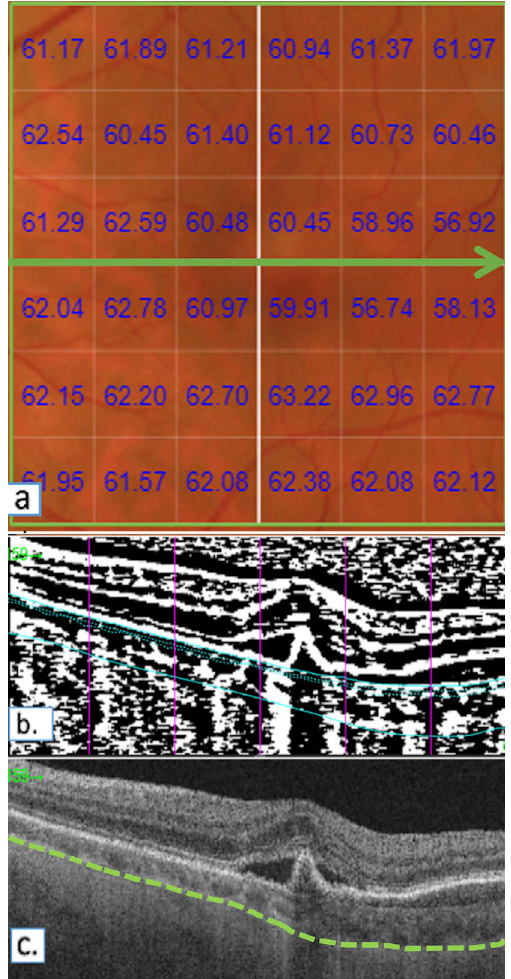
Figure 2. Choroidal vascularity index values generated using structural scans acquired with the swept- source OCTA protocol. ( a ) Automatically generated volumetric CVI values superimposed over the 6 × 6 mm macular area. ( b ) Representative binarized SS-OCT image using Niblack binarization technique at the location of the green arrow. The vertical pink lines indicate the position along the B-scan, in relation to the En-face image. The solid blue lines indicate the inner and outer borders of the choroidal segmentation. i.e. bruch’s membrane and choroid-scleral interface respectively. The dotted blue further segments the ‘inner choroid’. ( c ) Original SS-OCT image at the green arrow. The green line represents the manually marked choroid-scleral